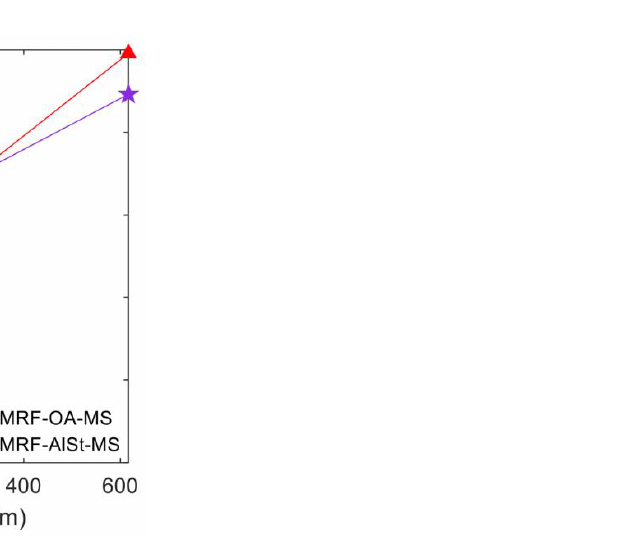
Figure 3. Influence of the surfactant type: yield stress values τ 0 obtained from the fit to the Herschel-Bulkley expression, for the different applied magnetic field intensities. Table 2. Summary of the values of the different parameters obtained when using the Herschel-Bulkley model, for all the magnetorheological fluids analyzed in this work.